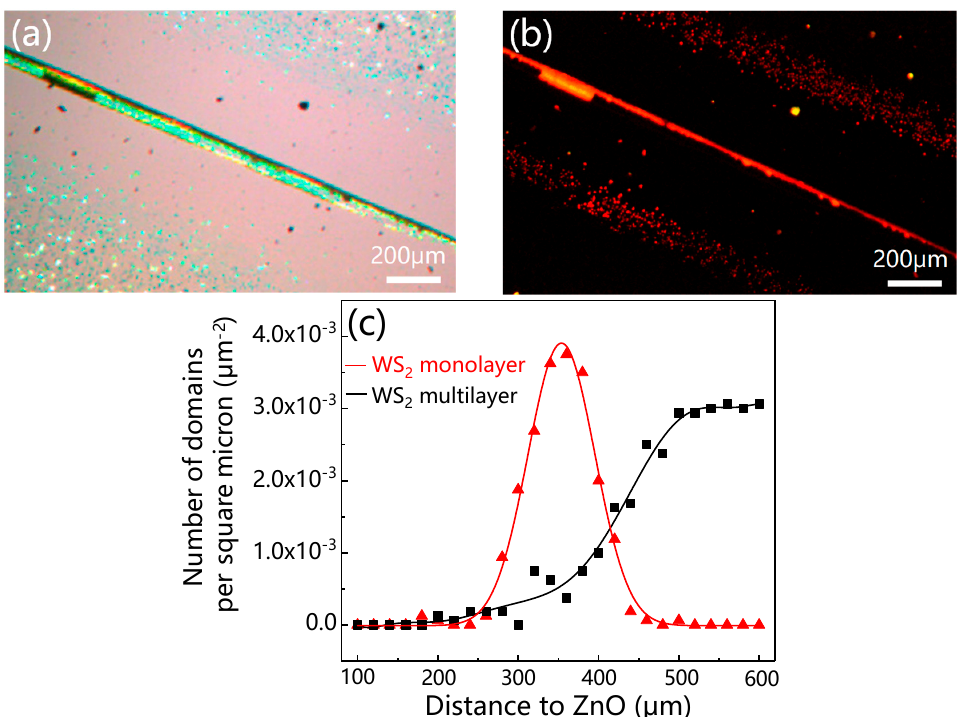
Figure 5. ( a ) The optical image of WS 2 domains prepared with the assistance of ZnO whisker. ( b ) PL image corresponding to the image of ( a ). ( c ) WS 2 domain distribution is a function of distance from the ZnO whisker. The origin is the ZnO crystal whisker. ( a ) and ( b ) were taken at the same location. The straight lines are related to ZnO whisker and the scale bars represent 200 μ m.